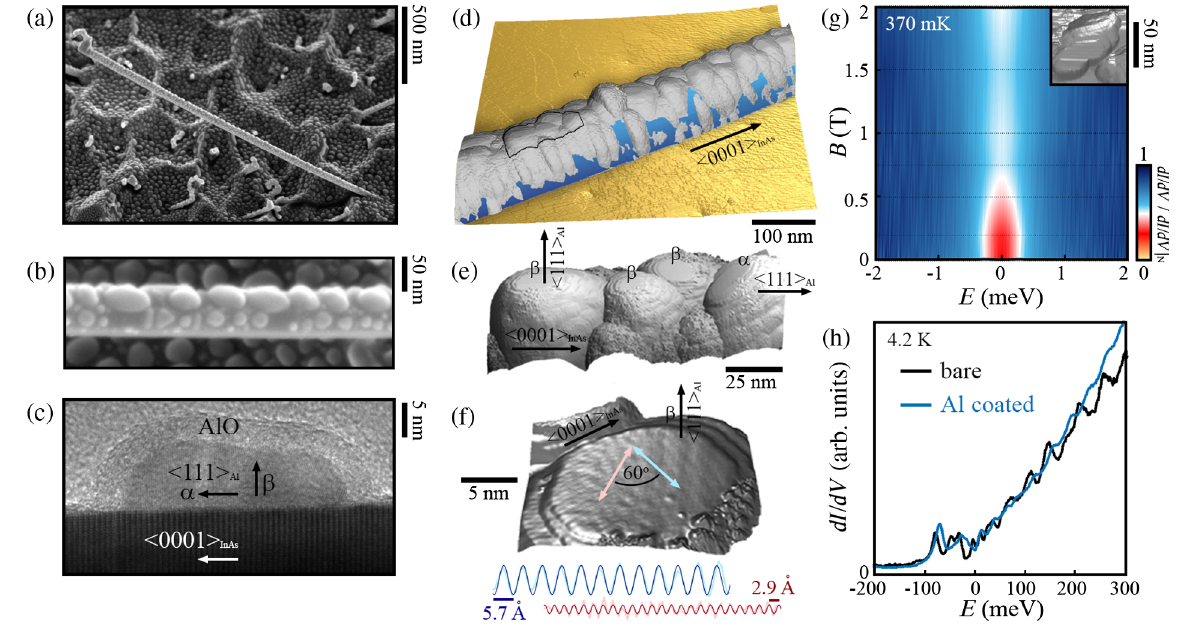
FIG. 1. (a) SEM image of an InAs nanowire covered with epitaxially grown Al islands. (b) Enlarged SEM image of such a nanowire. The large islands grow on the facet directed toward the Al evaporation cell. They have a slightly elongated shape since their growth is constrained by the 30 nm width of the nanowire facet. Smaller islands form on the side facets. (c) TEM image showing the clean interface between the nanowire and an oxide layer of about 5 nm that builds upon exposure to ambient conditions. The imaged island is composed of two Al crystallites in different orientation of their h 111 i fcc lattice. (d) False-color STM topographic image of an InAs nanowire (blue) on a gold substrate (yellow) covered with Al islands (gray). (e) Enlarged topography of the four Al islands marked in (d) showing distinct orientations of the crystallites ’ top facets corresponding to the α and β Al growth directions. (f) The topmost facet of each crystallite is atomically flat, revealing the Al crystal structure. Two topographic profiles taken across that island at the locations marked by pink and light blue arrows are shown in the bottom of the panel in corresponding colors. They are fitted with sinusoidal profiles in red and blue, respectively, revealing a doubled periodicity along one. (g) Interpolated false-color plot of a dI=dV measurement on a larger island (topography in inset) showing the closure of the superconducting gap and the Coulomb blockade gap that remains at higher magnetic fields. Dashed black lines correspond to the actual spectra acquired at different magnetic fields and are shown in Fig. 5. (h) Representative dI=dV curves given in arbitrary units (arb. units) measured on a bare nanowire (black) and an exposed InAs segment of a nanowire deposited with Al islands (blue). In both cases the conduction band onsets at about 100 meV below E F